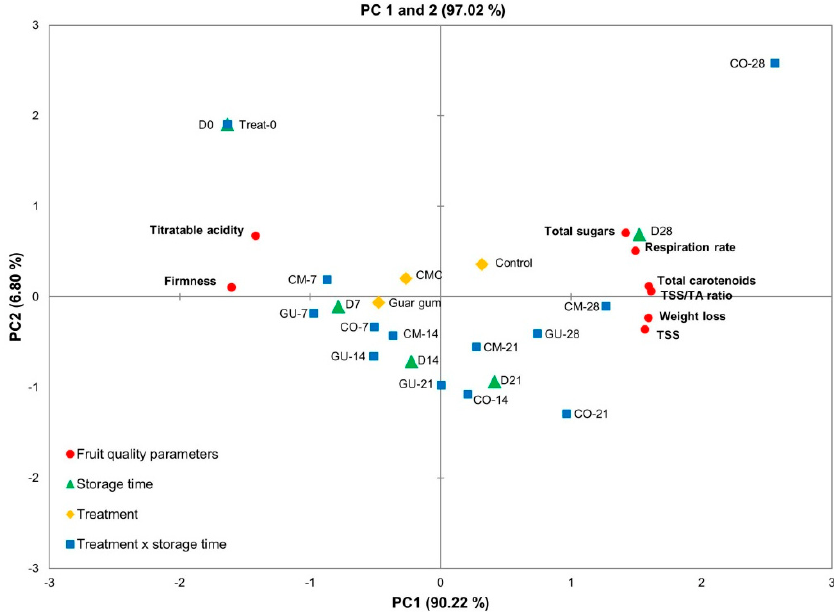
Figure 13. Principal component (PC) analysis (PC1: 90.2%, PC2: 6.8%) of the quality parameters of “Seddik” mango fruits over 28 days of storage period at 13 °C. D: day, CO: uncoated fruits, CM: CMC-AgNP-coated fruits, GU: guar gum-AgNP-coated fruits; numbers (0, 7, 14, 21, and 28) refer to the sampling dates.